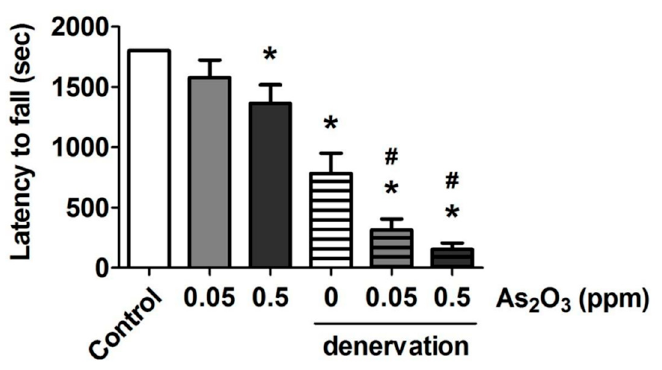
Figure 3 . Effects of As 2 O 3 on the muscle endurance in mice with or without denervation. As 2 O 3 (0.05 and 0.5 ppm) exposure from drinking water for 4 weeks in normal mice or denervated mice. Muscle endurance was determined as latency to fall in the muscle fatigue task with rotarod. Data are presented as the mean ± SEM ( n = 6 of each group). * P < 0.05 compared to the control group; # P < 0.05 compared to the denervation group.